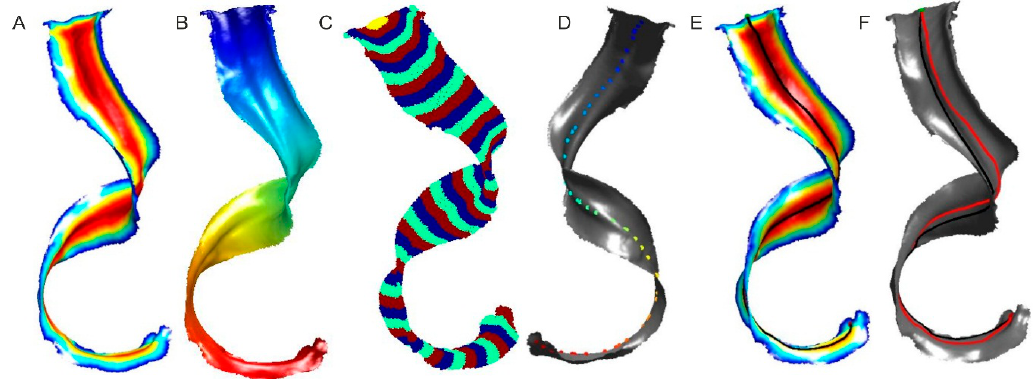
Figure 4. Steps to determine the length of a leaf: ( A ) Map of distances from the edge of the leaf; ( B ) Map of distances from the starting point to the endpoint; ( C ) Area division; ( D ) Vertices furthest away from the edge; ( E ) The shortest path; ( F ) Comparison of the path through the middle of the leaf (red line) and the shortest path in the geometric sense (black line) [37].